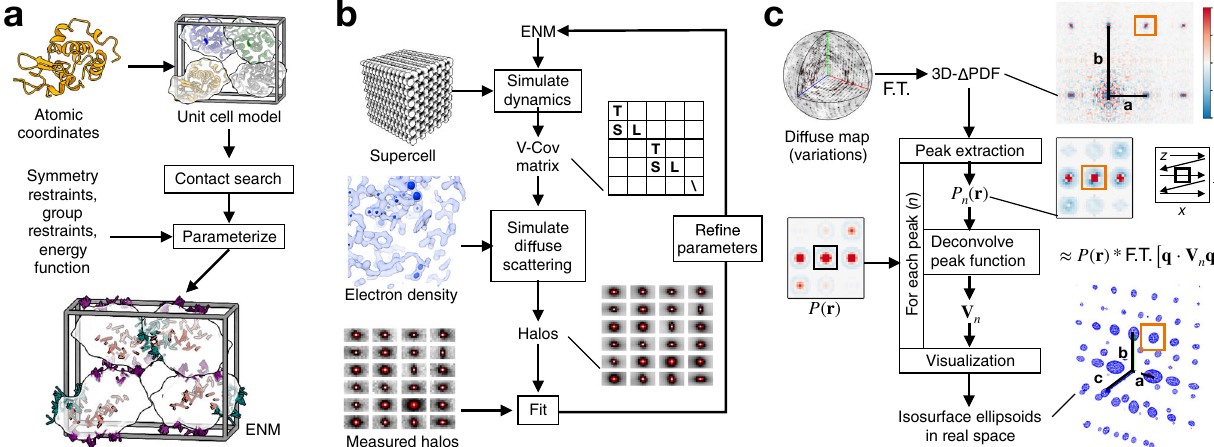
Fig. 2 | Lattice disorder modeling with GOODVIBES and DISCOBALL. a Preparation of a rigid-body elastic network model (ENM) for GOODVIBES re fi nement illustrated using lysozyme in the P2 1 2 1 2 1 space group. Rigid bodies (white surfaces) are joined by springs with re fi neable energy functions. The para- meterization step enforces space group symmetry and groups springs to avoid over fi tting. In this example, springs are grouped according to unique protein- protein interface (sticks colored orange, teal, and purple). b GOODVIBES re fi ne- ment of the ENM to fi t diffuse halos. At each iteration, the variance-covariance matrix of rigid body motion (V-Cov) is computed from the ENM by simulating the thermally-excitedvibrationsofalargesupercellwithperiodicboundaryconditions. The halo scattering pro fi les are simulated from V-Cov and the electron density of